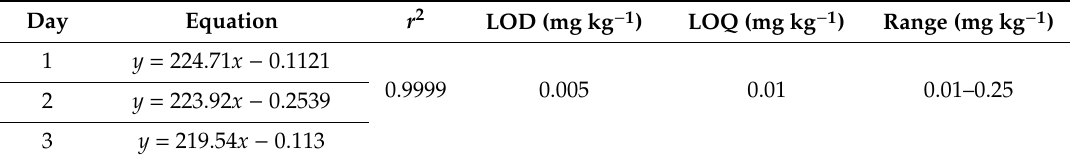
Table 5. Linearity, limit of detection and quantification of BPA according to the International Conference on Harmonisation (ICH) guidelines Q2 (R1), and using high-performance liquid chromatography (HPLC) with fluorescence detection